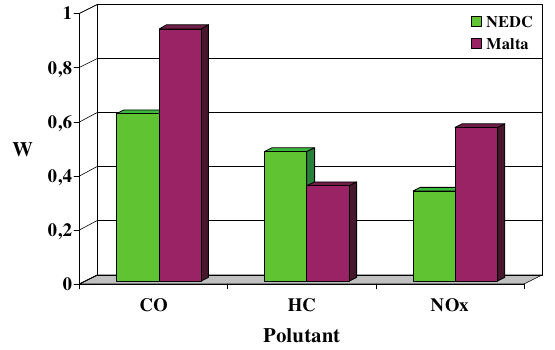
Fig. 30. Comparison of the mean hydrocarbons emission value in the test Fig. 33. The coefficient of variation of the average emission intensity and in the states corresponding to the negative, zero and positive values of value in individual elementary states of dynamic rotational speed variation the engine torque derivative with respect to time – for the NEDC and Malta tests